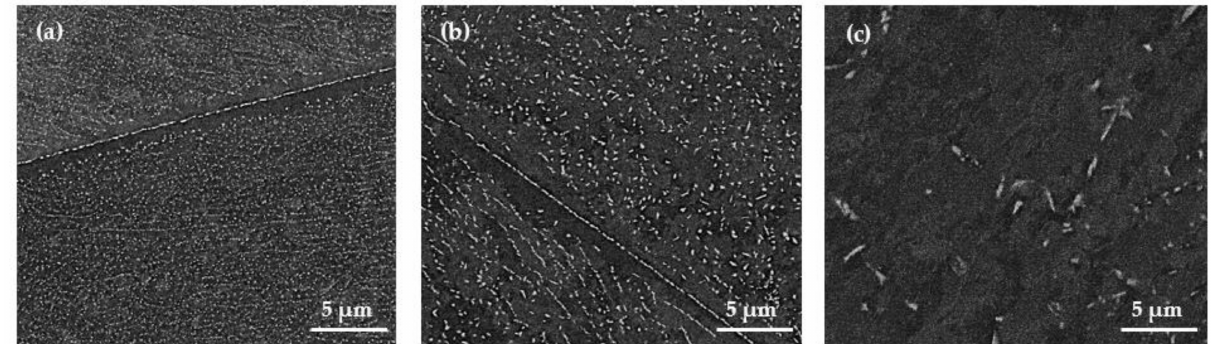
Figure 2. Representative SEM-BSE micrographs of thermomechanically induced Laves phase precipitation in the model alloy Fe17Cr2.6W1Nb created by deformation temperature at 800 ◦ C ( a ) laboratory-scale forging—deformation grade of ϕ = 0.5; ( b ) laboratory-scale forging—deformation grade of ϕ = 0.2 and ( c ) industrial-scale two-step forging—final deformation grade of ϕ = 0.5.